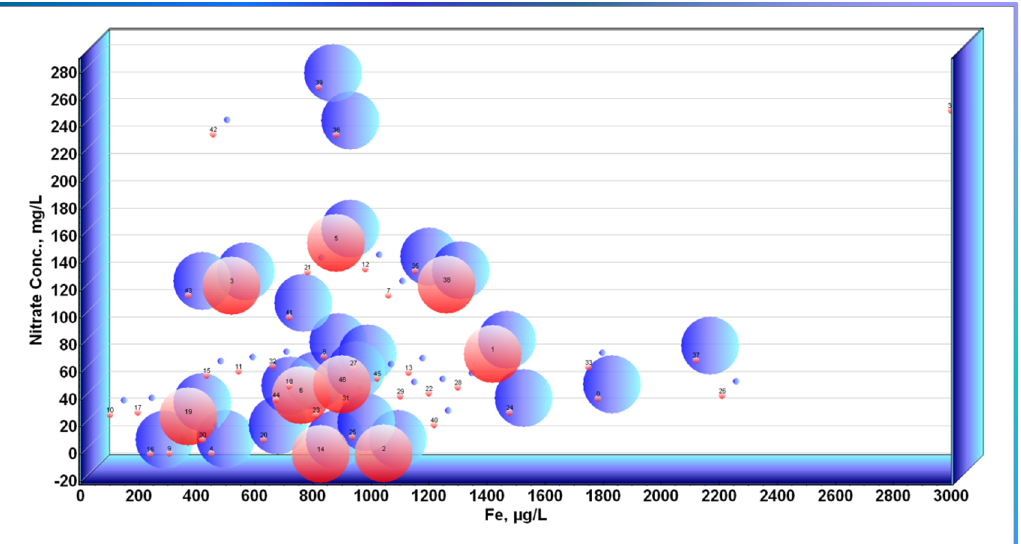
Figure 10. Bubble plot of the Nitrate and Fe concentrations combined interaction on TC ( blue ) and E. coli ( red ).